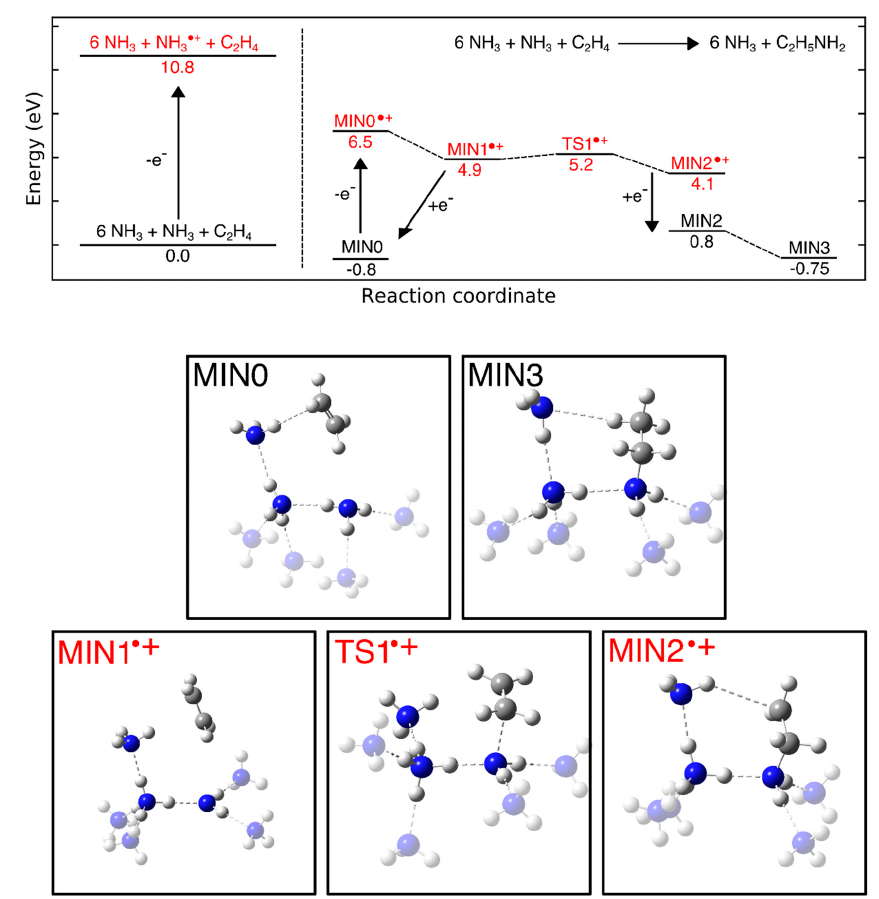
Figure 17. Reaction pathway of the ionization ‐ driven hydroamination reaction of ethylene (C 2 H 4 ) and NH 3 leading to ethylamine (C 2 H 5 NH 2 ) calculated on the B3LYP/6 ‐ 311 + G(d) level of theory. The condensed phase environment was modelled by embedding the reactants in a cluster of six additional NH 3 molecules. For comparison, the energies of the isolated molecules relative to their ground states is included on the left side of the energy diagram. The calculations were performed with the Gaussian 98 package [121]. All energies are given relative to the sum of the isolated reactant molecules. The geometries are snapshots on the potential energy surface along the proposed reac ‐ tion path. Note, that the geometries are no true minima or transition states. However, the remaining imaginary modes are very small and can all be associated with rotational modes of the NH 3 moieties. The true minima and transition states thus should not deviate much from the geometries presented herein. It is also conceivable that the addition of a neutral radical to C 2 H 4 is an alternative to the EI ‐ driven hydroamination in the case of C 2 H 4 /NH 3 mixed ices. Here, NH 2 ⦁ radicals, that can for instance be formed by ND (Section 3.3), would add to the double bond of C 2 H 4 . This would yield an intermediate H 2 N–C 2 H 4 ⦁ radical which may then abstract a H • from a nearby NH 3 to convert to ethylamine (Scheme 3). This type of reaction is also closely related to the mechanism presented in Figure 17 where the NH 2 ⦁ radical results from hydrogen transfer from a neutral NH 3 to an ionized NH 3 ⦁(cid:3397) radical cation. Whether ND contributes to the yield of ethylamine can likely be unraveled by photon irradiation